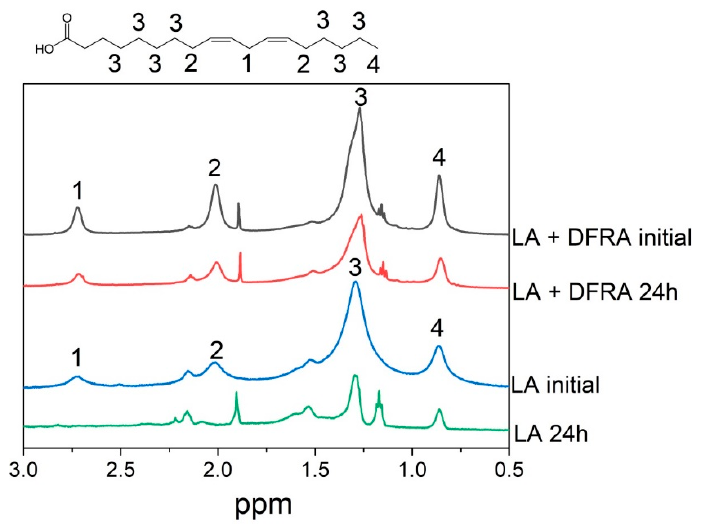
Figure 4. Chemical structure of linoleic acid (LA) and fragments of 1 H-NMR spectra of the initial LA (3.5 mM) and the reaction mixture with H 2 O 2 (0.5 M) and FeSO 4 (0.1 mM) after 24 h in the absence and in the presence of deferasirox (DFRA, 2 mM). The studies were carried out at room temperature, in buffer solution (0.1 M) of pH 7.4. LA protons and their corresponding signals in the fragments of 1 H-NMR spectra are designated by numbers 1–4.